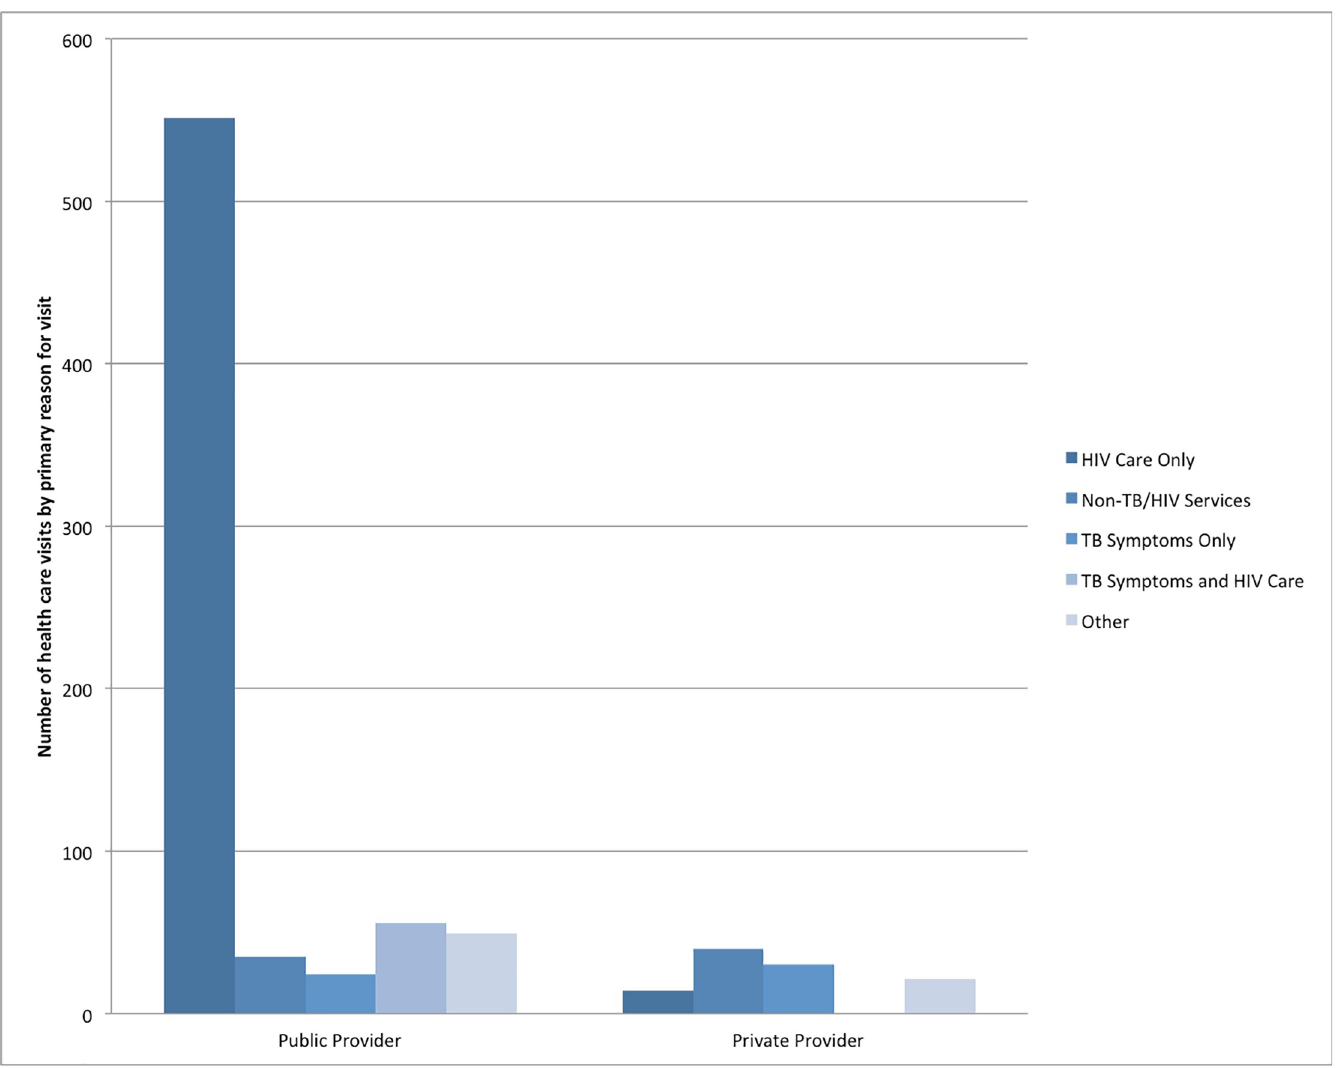
Fig 1. Reasons for seeking healthcare among pre-ART patients. Respondents were asked about their health service utilisation and reasons for service utilisation in the last 3 months; this was based on the responses of 277 respondents (a total of 715 visits). 76 (105 visits) respondents utilised services at a private provider.